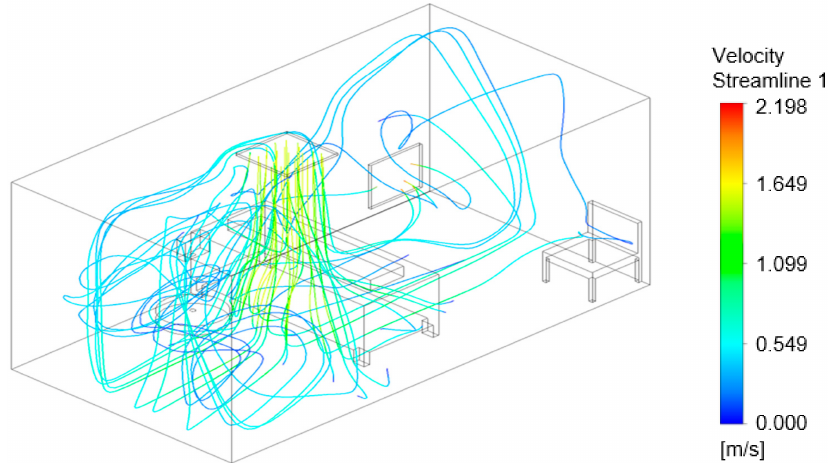
Figure 17. Computational flow model showing airflow velocity streamlines for configuration ‘b’.